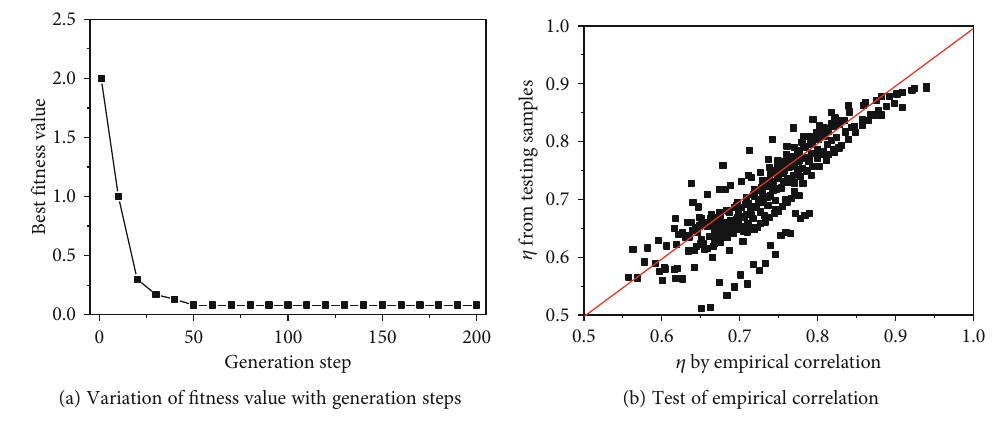
Figure 23: GA optimization for the parameters in empirical correlation. Table 4: Values for parameters in the empirical correlation.